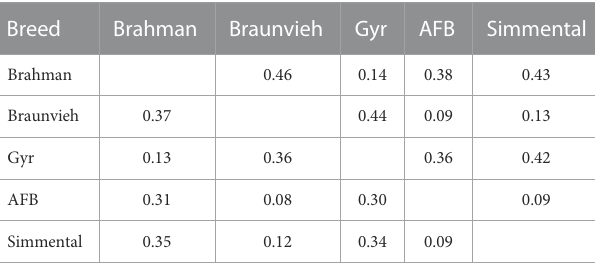
TABLE 3 Estimates of the pairwise genetic differentiation statistic (F ST statistics; below the diagonal) and the Reynold ’ s genetic distance (above the diagonal) among fi ve cattle